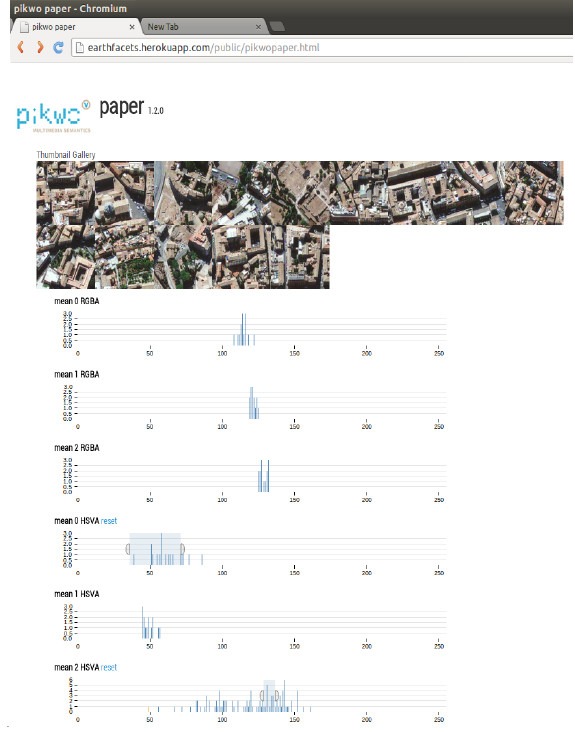
Figure 7: Search/Filtering results for class ”Historical Build- ings”: the selection of specific Hue and luminosity intervals are sufficient for the selection of this very populated image class in our example data